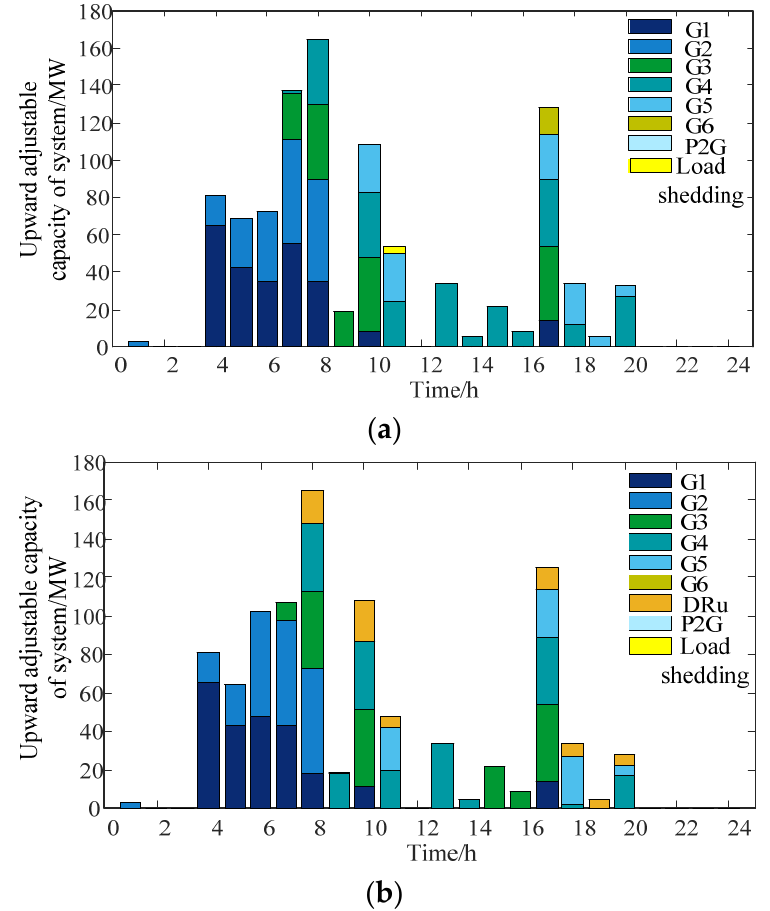
Figure 7. Power system upward adjustable capacity in different Cases: ( a ) Case3; ( b )